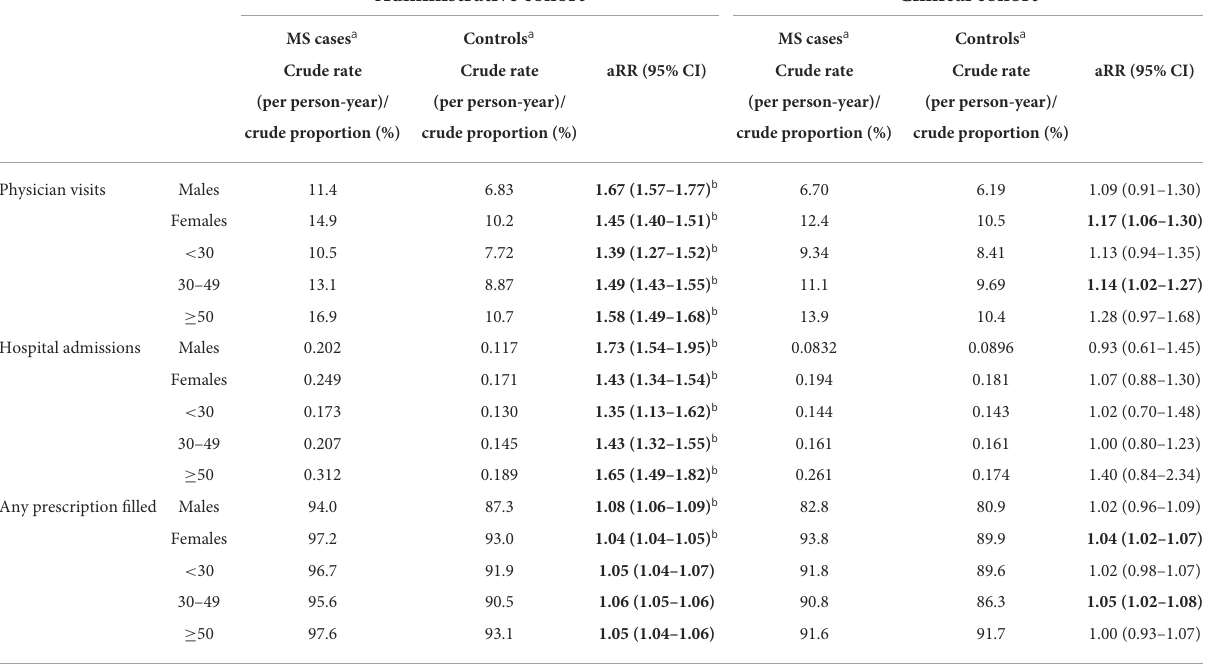
TABLE 2 Sex and age-specific differences in health-care use for any reason between multiple sclerosis cases and controls: 5 years before the index date in the health administrative and clinical